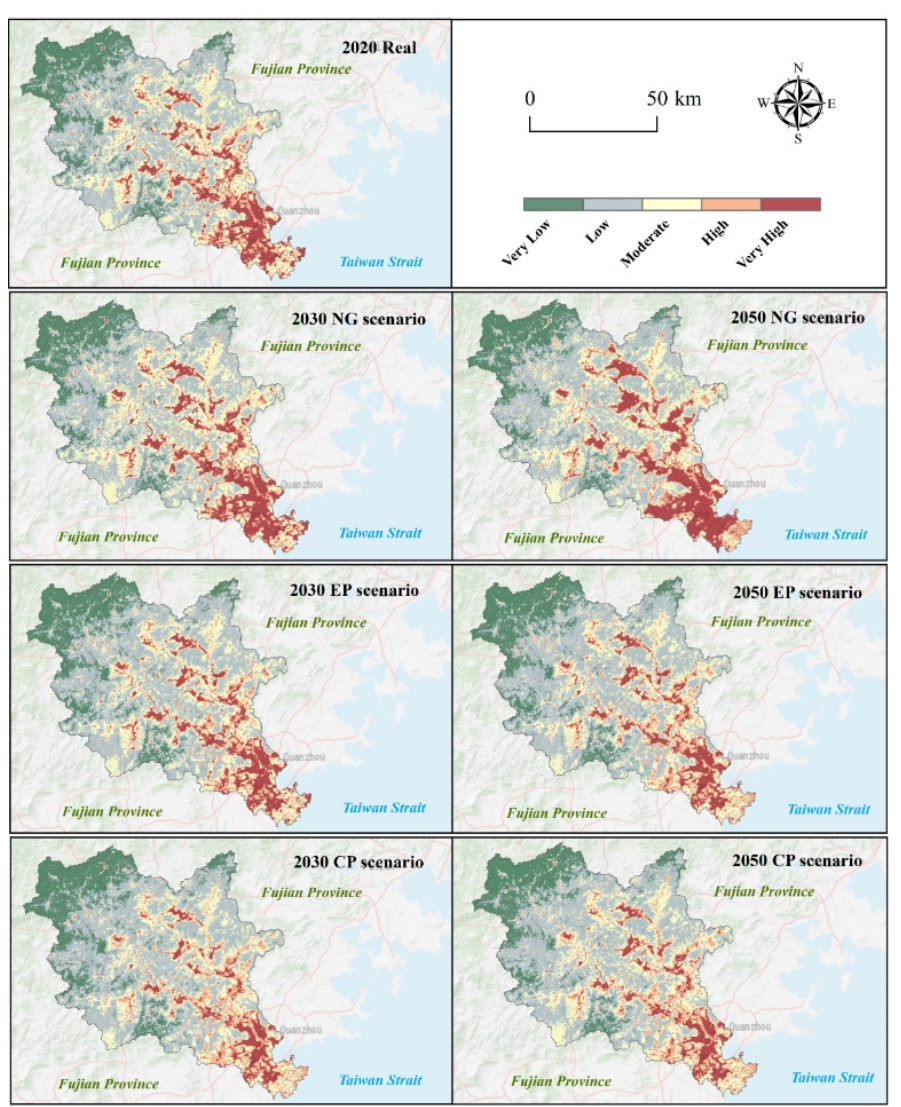
Figure 11. The future flood risk maps under the three scenarios from 2030 to 2050 in Jinjiang Basin. NG, EP, and CP scenarios represent natural growth, ecological protection, and cropland protection scenarios,